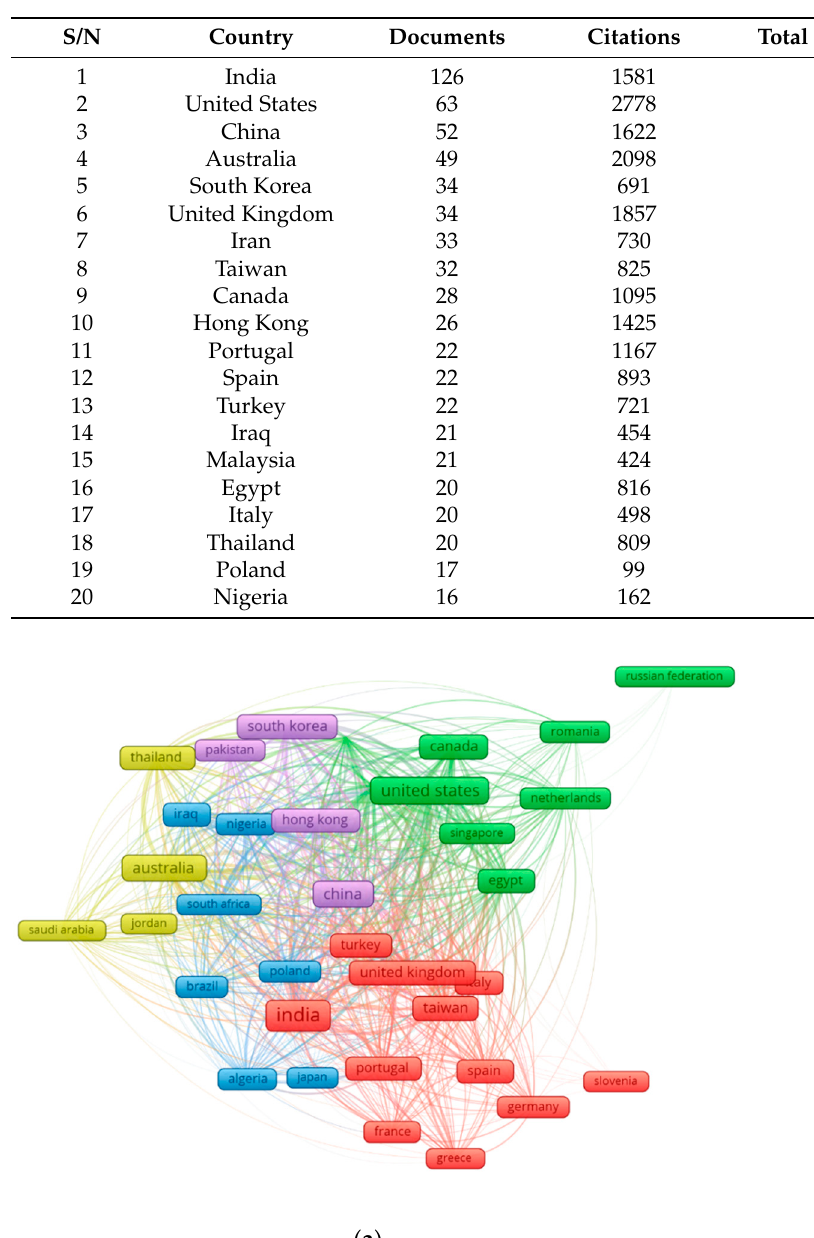
Table 5. Top 20 contributing countries.